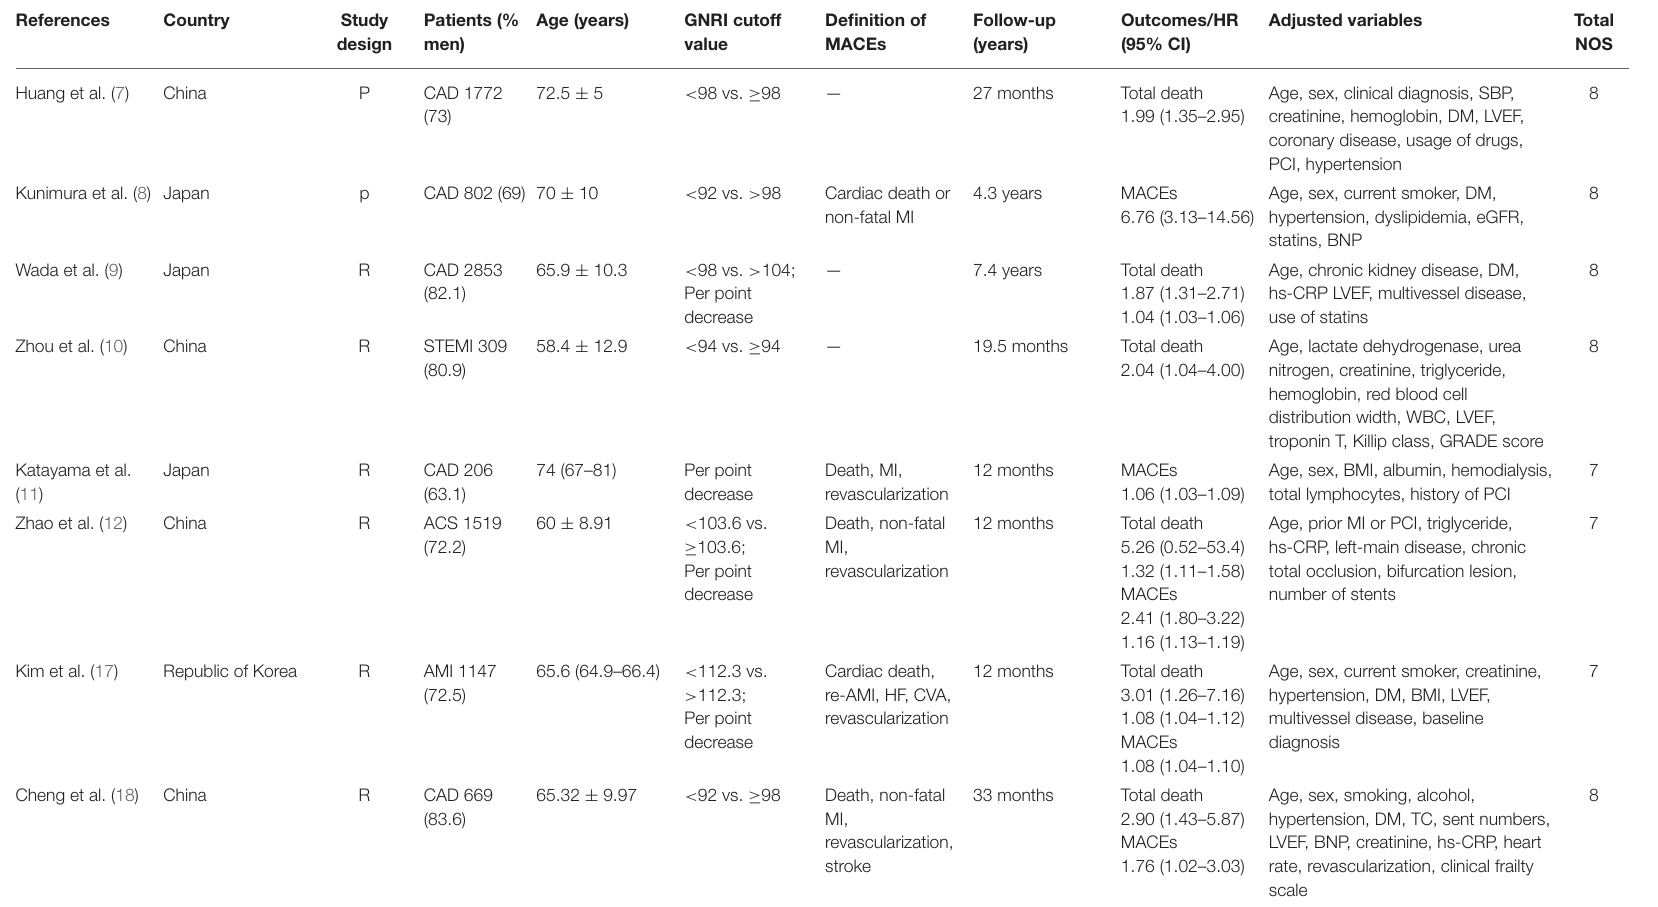
TABLE 1 | Main characteristics of the included